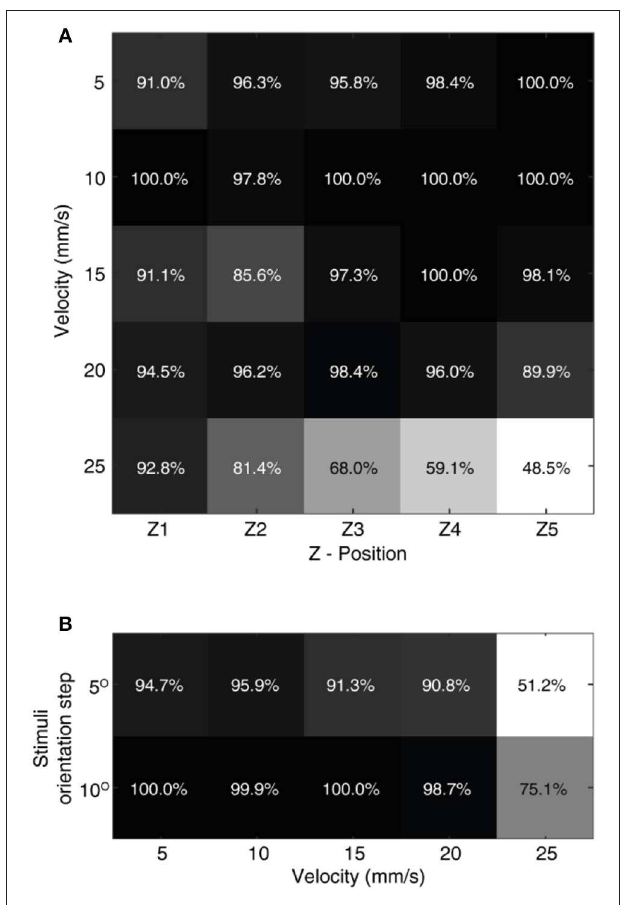
FIGURE 10 | Effect of sensing dynamics on decoding. (A) The decoding performance achieved by CNs neurons across all the 9 stimuli, for a given combination of sensing force and sensing velocity. The confusion matrix for each given decoding performance is illustrated in Supplementary Figure 1 . (B) Generalized decoding performance (irrespective of sensing force), achieved by CNs for a given sensing velocity. The decoding accuracy was presented across all 9 stimuli (S1–S9) with a step size of 5 ◦ , and across 5 stimuli with a step size of 10 ◦ (S1, S3, S5, S7, and